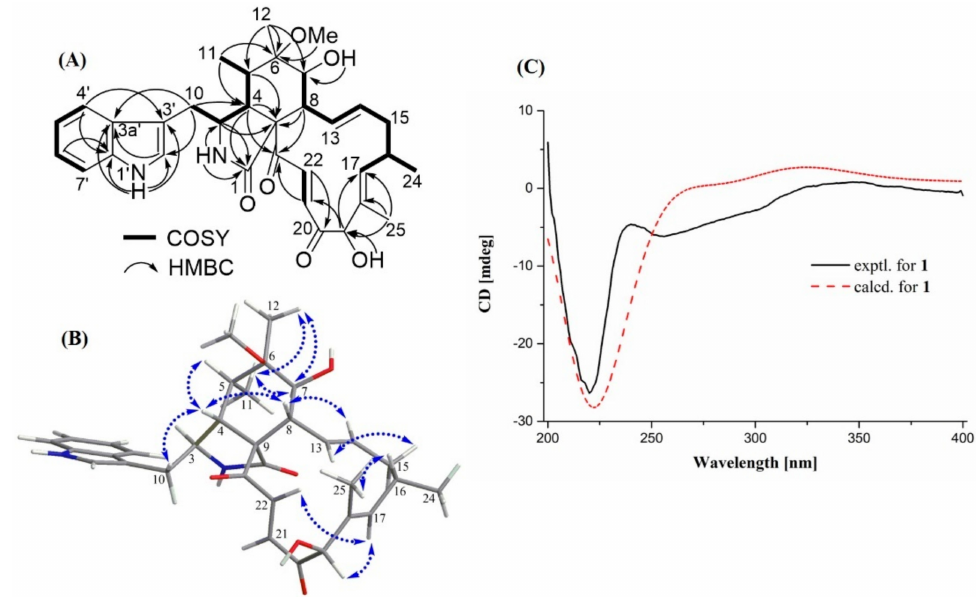
Figure 2. Key HMBC, COSY ( A ), and NOESY ( B ) correlations, and the experimental and calculated ECD spectra ( C ) of 1 .